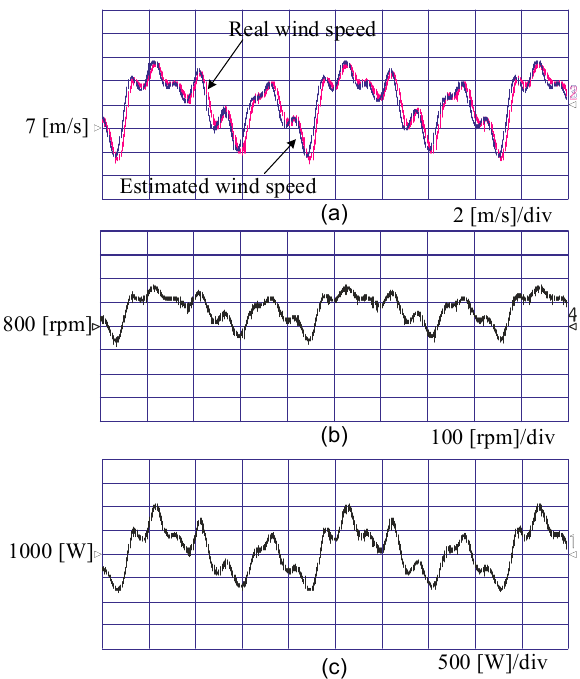
Figure 16. Experimental results for continuously variable wind speed: ( a ) Real and estimated wind speed, ( b ) generator speed, and ( c ) generator power.